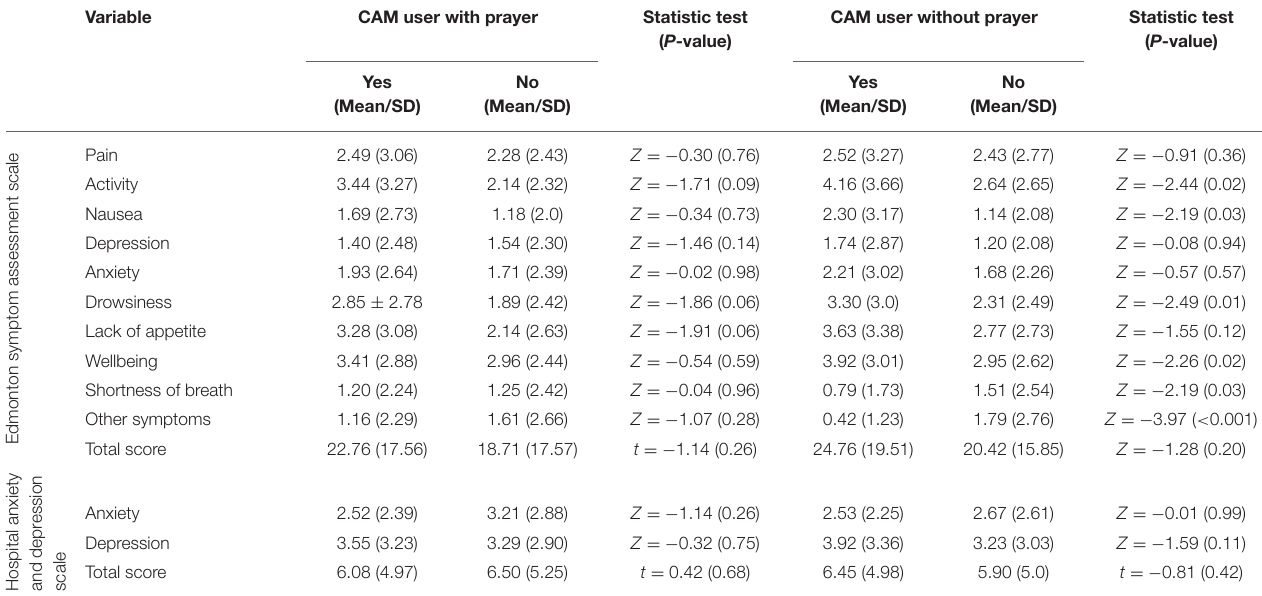
TABLE 4 | The psychosomatic symptoms of terminally ill cancer patients and its association with CAM usage.